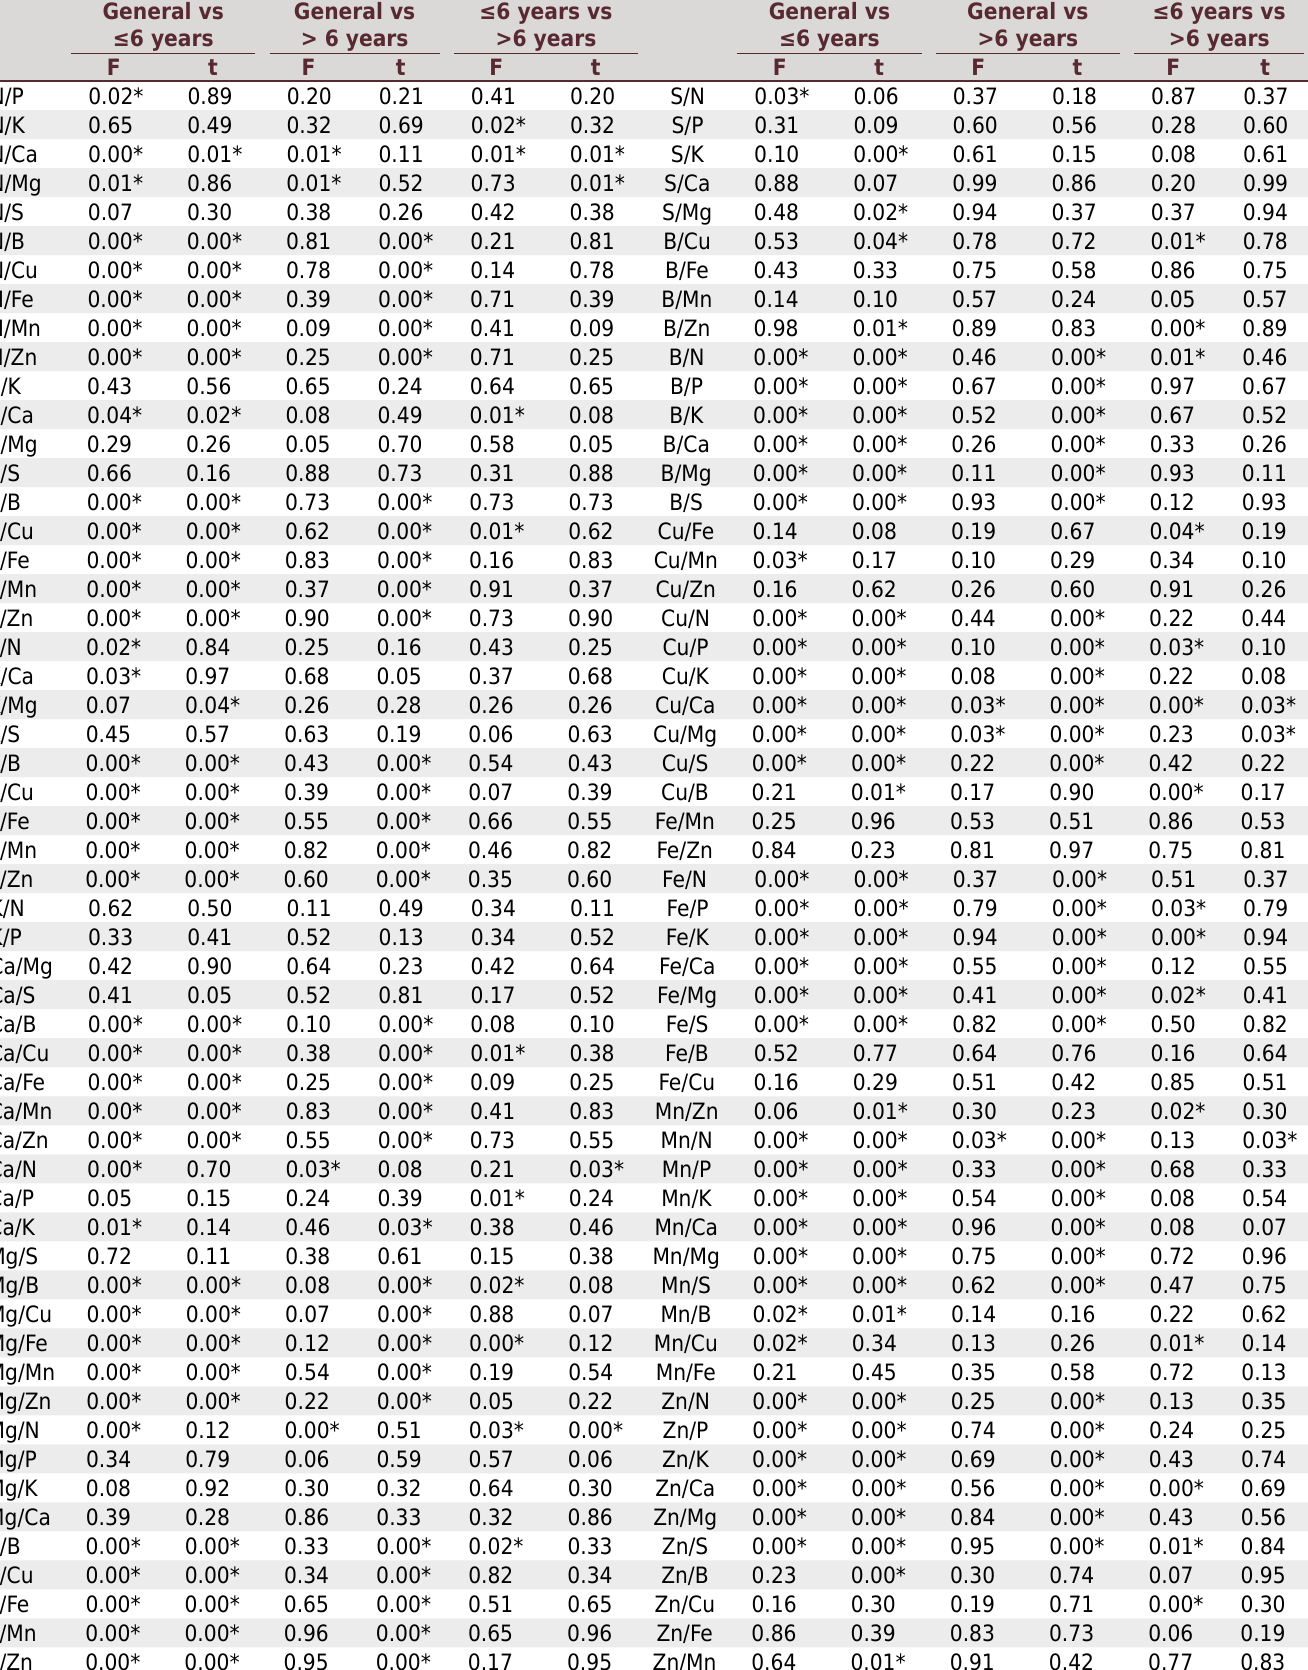
Table 5. Probability values (p-value) obtained in F test and Student’s t test for comparison of relationships calculated in a general reference population (indiscriminately for genetic material and ages) and for specific reference populations with young (≤6 years after planting) and adult (>6 years after planting)